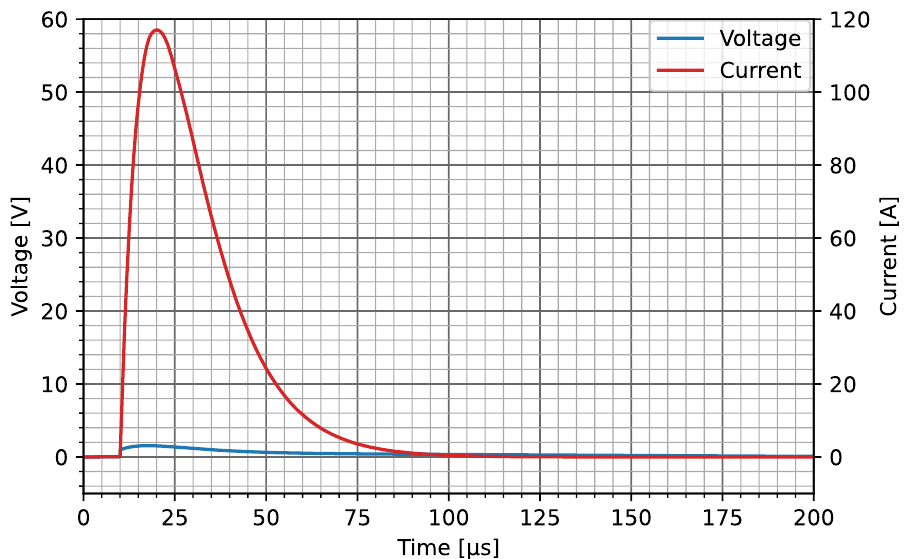
Figure 32. LTspice simulated voltage and current plots for a large transient stimulus applied in the for- ward bias.